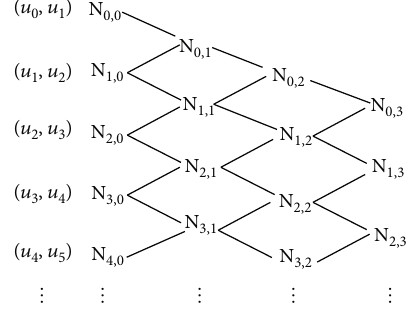
Figure 6: B-spline basis function subnode